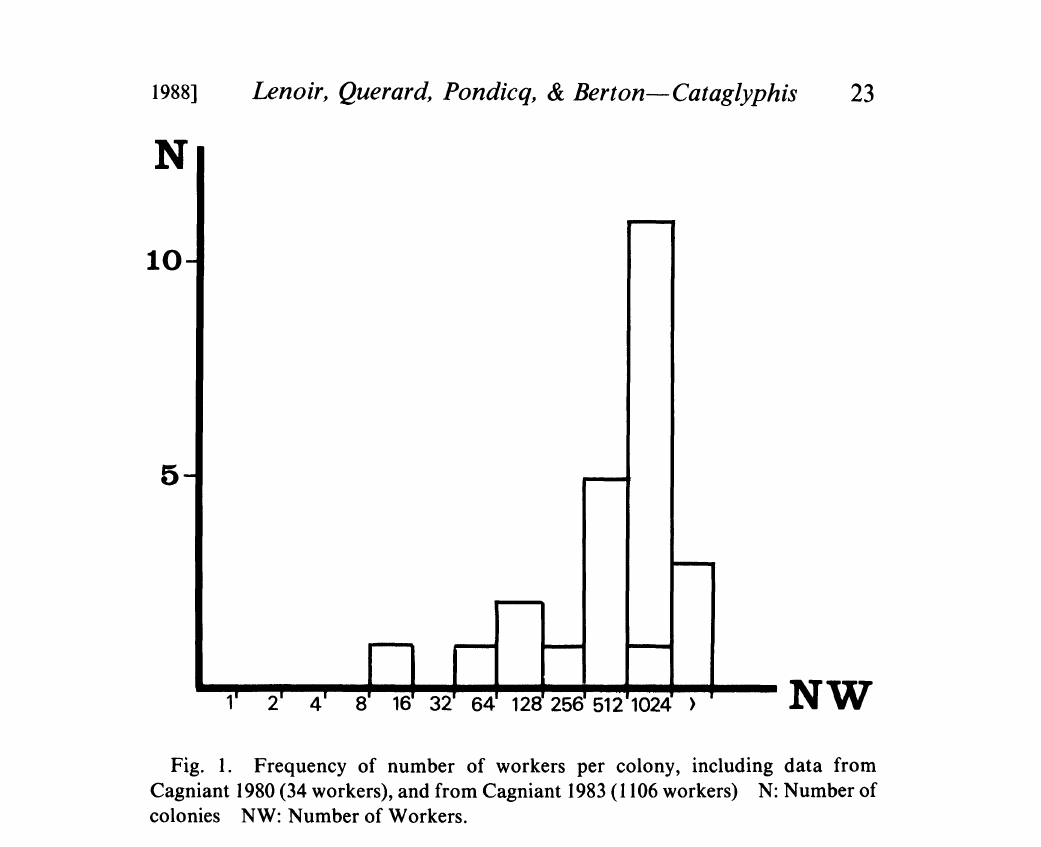
Fig. 1. Frequency of number of workers per colony, including data from Cagniant 1980 (34 workers), and from Cagniant 1983 (1106 workers) N: Number of colonies NW: Number of